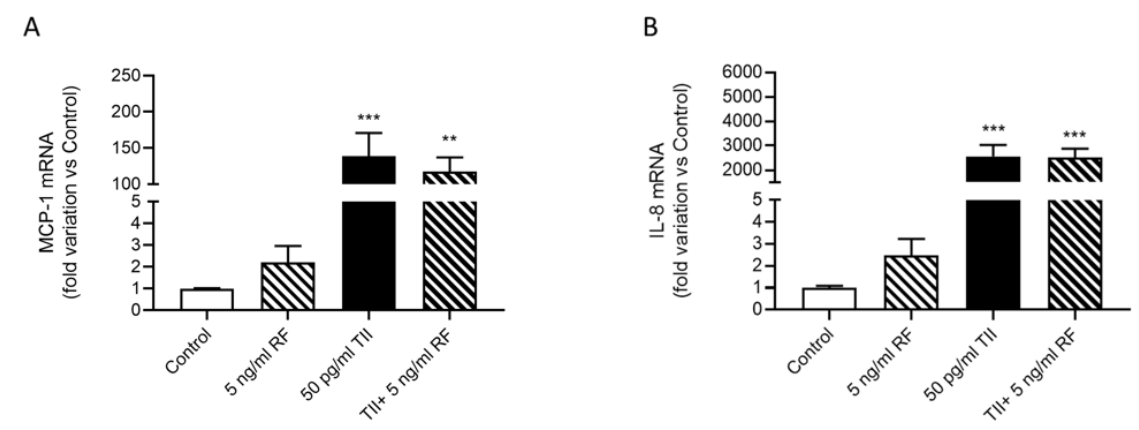
Figure 5: Effects of remifentanil (RF) on IL-8 and MCP-1 expression. C20 cells were treated with 5 ng/ml RF alone or in combination with 50 pg/ml TII for 16 h. ( A ) MCP-1 and ( B ) IL-8 mRNA levels were assessed by real-time qPCR. Results are pooled analysis of three independent experiments. Data are expressed as fold variation vs Control, means ± SEM (n=7-9) and were analyzed by one-way ANOVA followed by the Bonferroni's post hoc test. **, p<0.01; ***, p<0.001, versus